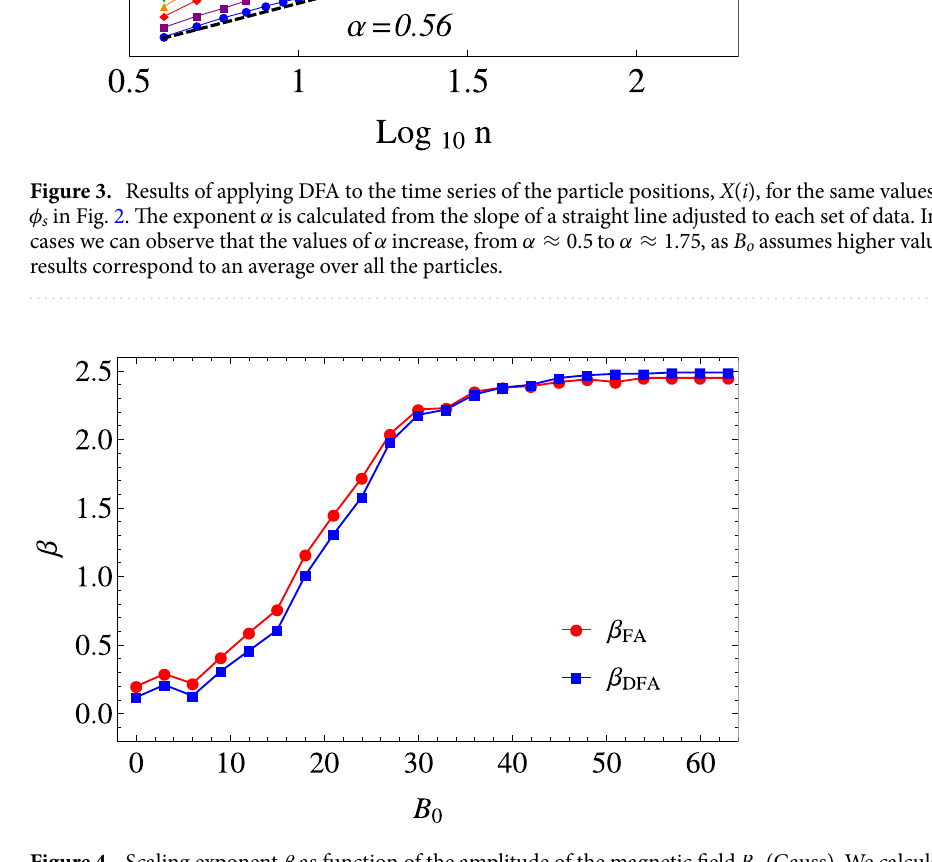
Figure 4. Scaling exponent β as function of the amplitude of the magnetic field B o (Gauss). We calculate the exponents by applying FA ( β FA ) and DFA ( β DFA ). In both cases, we can observe a transition from β ≈ 0 to β ≈ 2.5 , as B o increases, i.e. a transition from noncorrelated time series to correlated times series. Error bars are not shown since they are of the order of the symbol